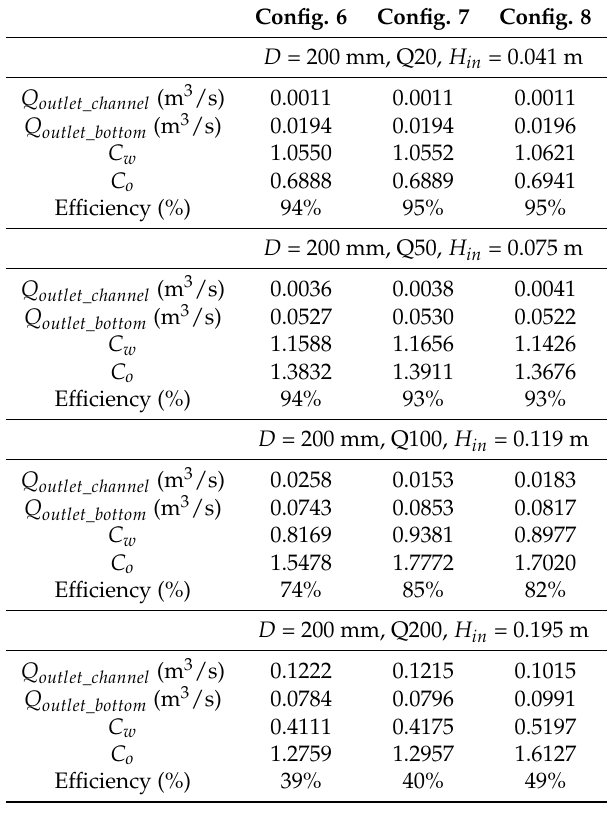
Table 9. Discharges, coefficients and efficiency for gullies with different bottom outlet location ( D = 200